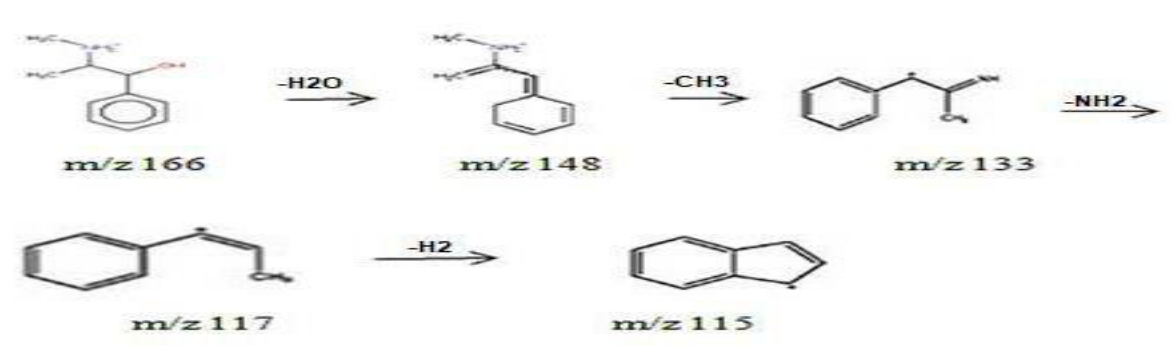
Figure 14. Structural elucidations of AS2 fragmentations (31)(32) .